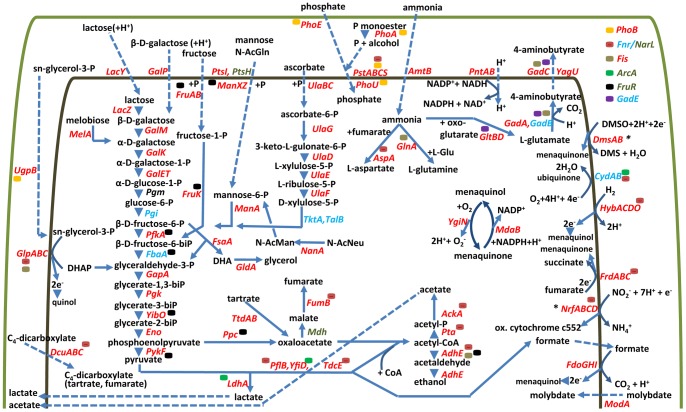
Metabolic pathways active in intestinal EHEC cells.From the left to the right: import and metabolism of glycerol derivatives and dicarboxylic acids; import of mono- and disaccharides and their entry into the glycolytic pathway (GP); metabolism of ascorbic acid; mixed acid fermentation utilizing GP products; high affinity phosphate and ammonia import and metabolism; NADPH generation and menaquinone/menaquinol cycle; glutamate decarboxylase acid resistance system (Gad); oxygen-dependent and -independent electron transport chains; *periplasmic electron transporters. Symbols/color codes: substrates and products of pathways are denoted in black script, proteins in red script (if increased in abundance in vivo), in blue script (if there was no abundance change but high expression in vitro and in vivo), in green script (if decreased in abundance in vivo); full arrows indicate a catalytic step, dotted arrows a transport step. In the top right corner, seven global transcriptional regulators are depicted; their color-coded symbols are included in the graphic to illustrate where they influence gene expression. The area between the green line (outer membrane) and inner line (inner membrane) represents the periplasmic space.